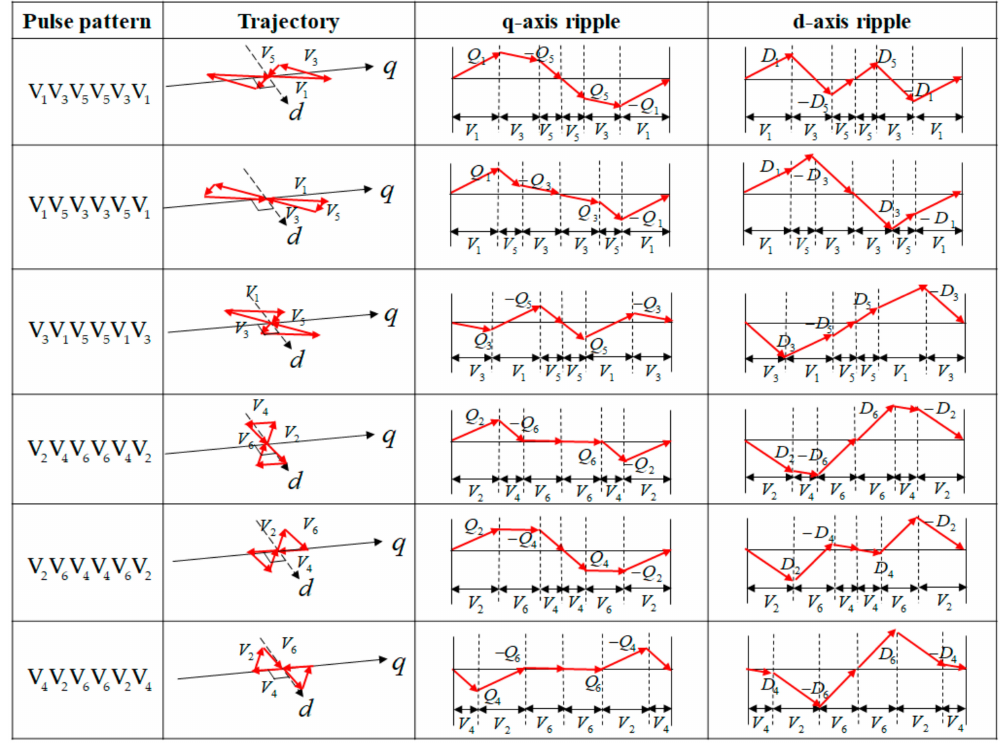
Figure 4. Trajectory of error voltage vector by six pulse patterns of RSPWM and corresponding d–q-axes current